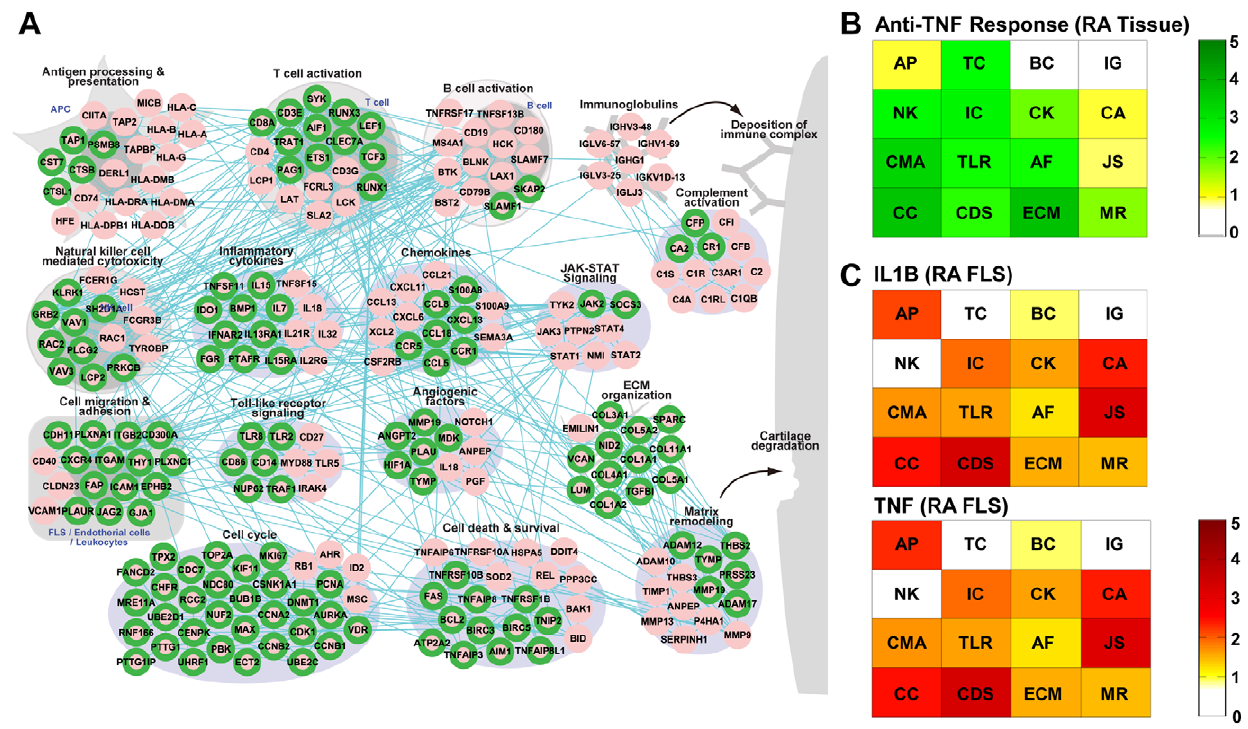
Figure 3. Signatures of anti-TNF inhibitors in RA-perturbed network. A) A RA-perturbed networks showing the recovery of the elevated RAGs to normality by anti-TNF therapy. Green border colors represent the decreases in expression levels of 136 elevated RAGs. B) and C) Module enrichment scores representing the significances of overlaps of the genes decreased by anti-TNF therapy (B) or the genes whose expression levels are elevated by IL1B and TNF treatments (C) with the genes belonging to the network modules. AP=Antigen processing & presentation; TC=T-cell activation; BC=B-cell activation; IG=Immunoglobulins; CA=Complement activation; NK=Natural killer cell mediated cytotoxicity; IC=Inflammatory cytokines; CK=Chemokines; CMH=Cell migration & adhesion; TLR=Toll-like receptor signaling; AF=Angiogenic factors; JS=JAK-STAT signaling; CC=Cell cycle & DNA repair; CDS=Cell death & survival; ECM=ECM organization; MR=Matrix remodeling.